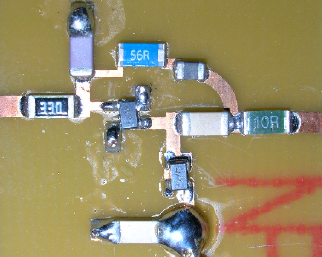
= 33 Ω , C = 680 pF, and c